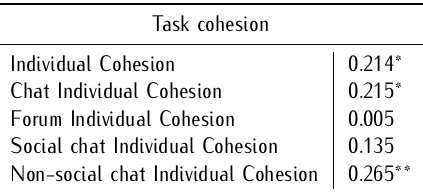
Table 5. Correlations between Individual cohesion measures and Task cohesion. * p < 0 . 1 , ** p < 0 . 05